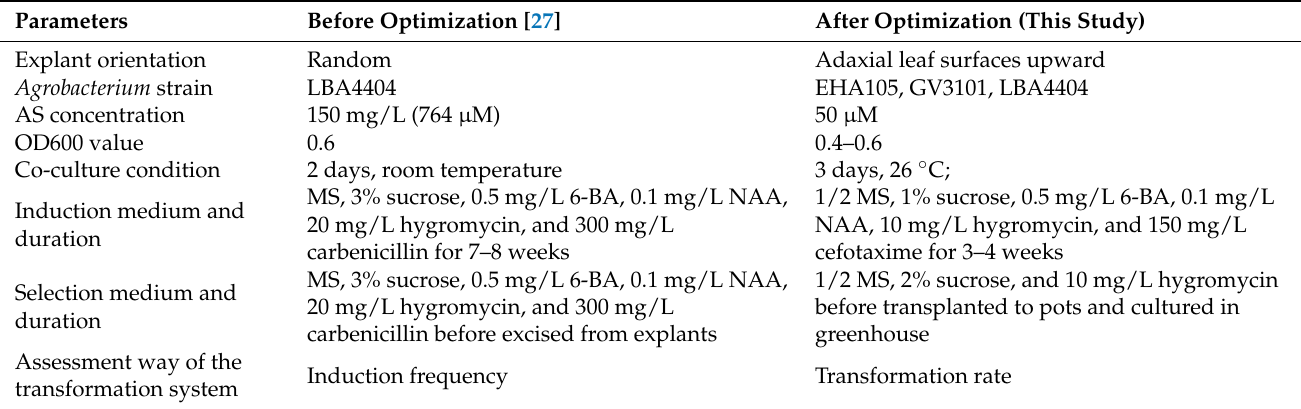
Table 4. Improvement of the transformation system of C . pumila in this